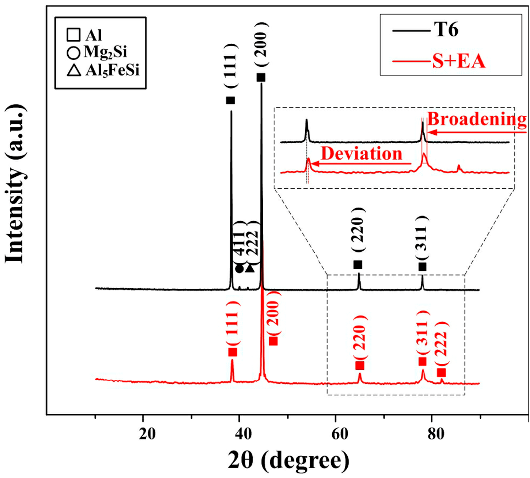
Figure 3. XRD spectrum of different samples.